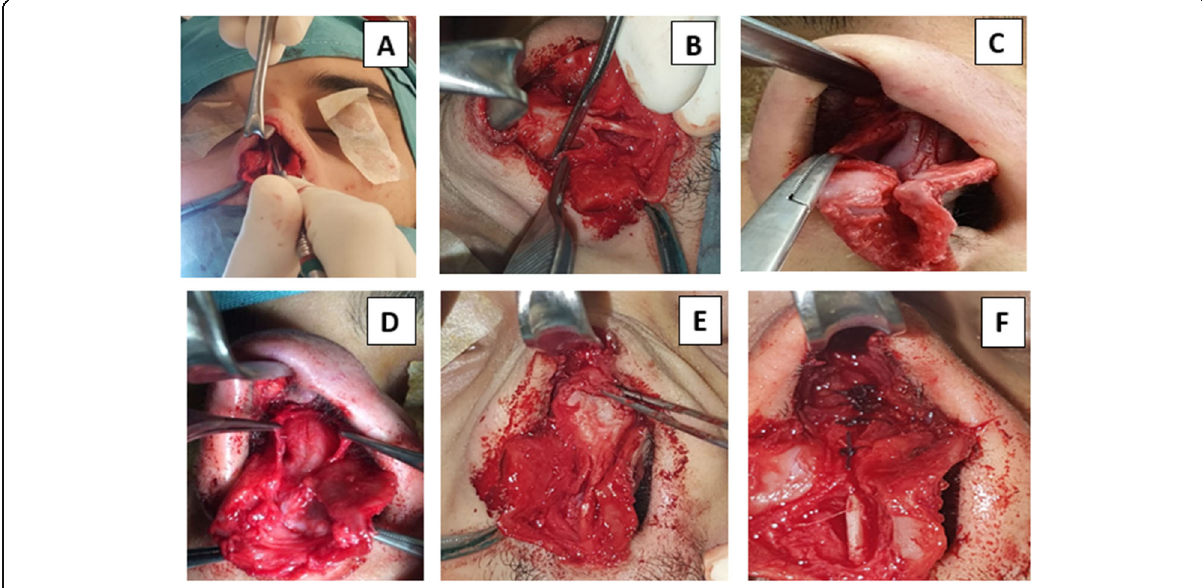
Fig. 1 Steps of modified perichondrio-periosteal flap. A Midline incision of the perichondrium. B Dissection of the perichondrium. C Right laterally based perichondrial flap. D Right and left elevated perichondrial flap. E Caudal edge of the periosteal flap. F Closure of the perichondrium by simple